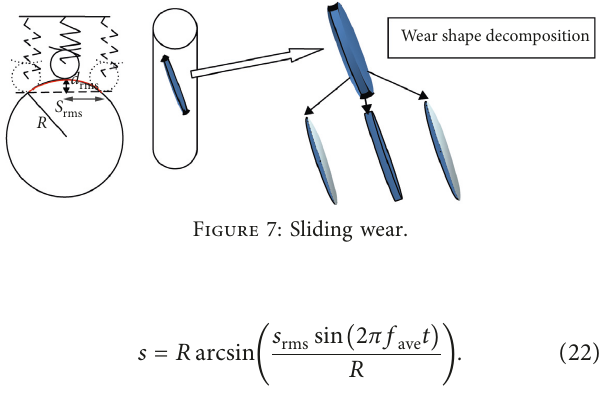
Figure 7: Sliding wear.